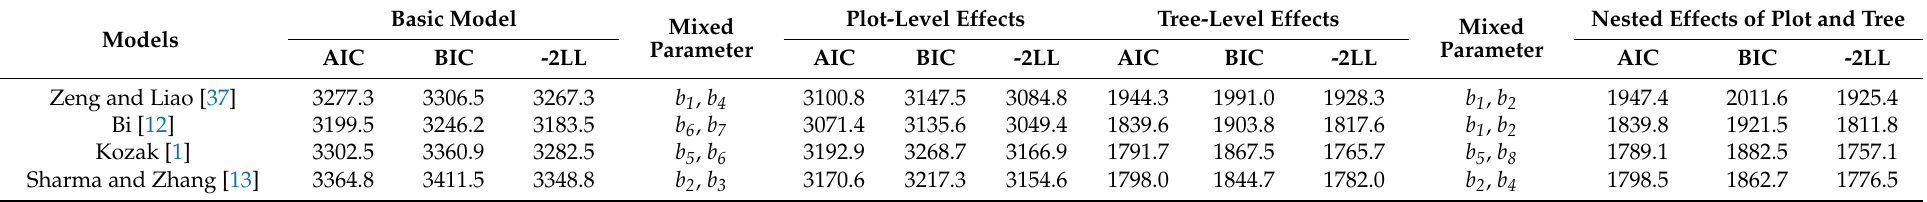
Table 4. Statistics of the Akaike information criteria (AIC), Bayesian information criteria (BIC), and -2loglikelihood (-2LL) for variable exponent taper models with different